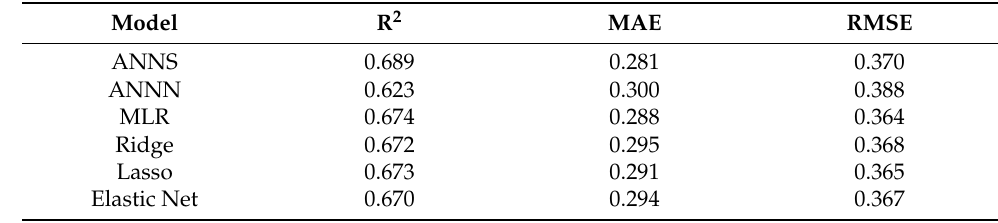
Table 6. Performance comparison of the